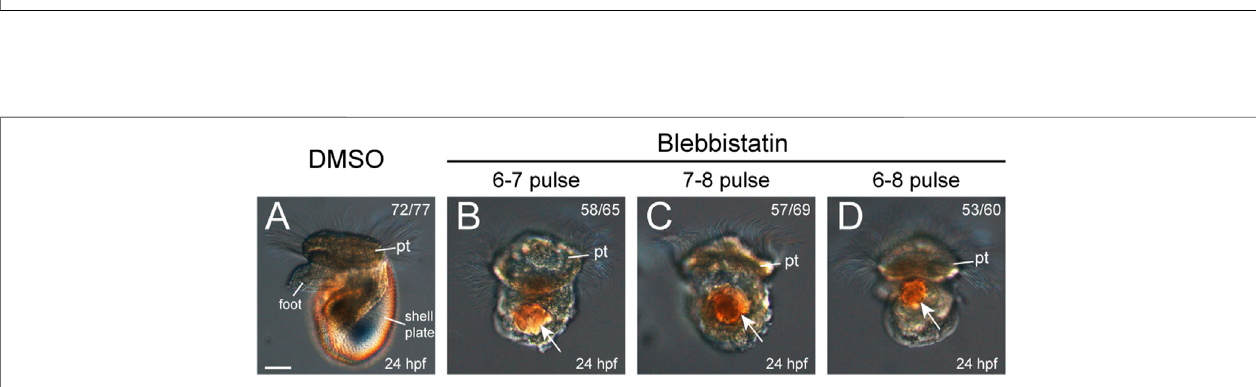
FIGURE3| Larvalphenotypes(24 hpf)afterblebbistatin treatments.Allpanelsshowimages captured underDICmicroscopy, withlateralviewsanteriortothetop. DMSO treatment in any time window did not generate detectable changes in development, and thus, the representative results from one group are shown (A) . Larval shell plates were not observed in the manipulated larvae, which only showed birefringence materials (white arrows in B – D ). pt, prototroch. The bar represents 25 μ m.